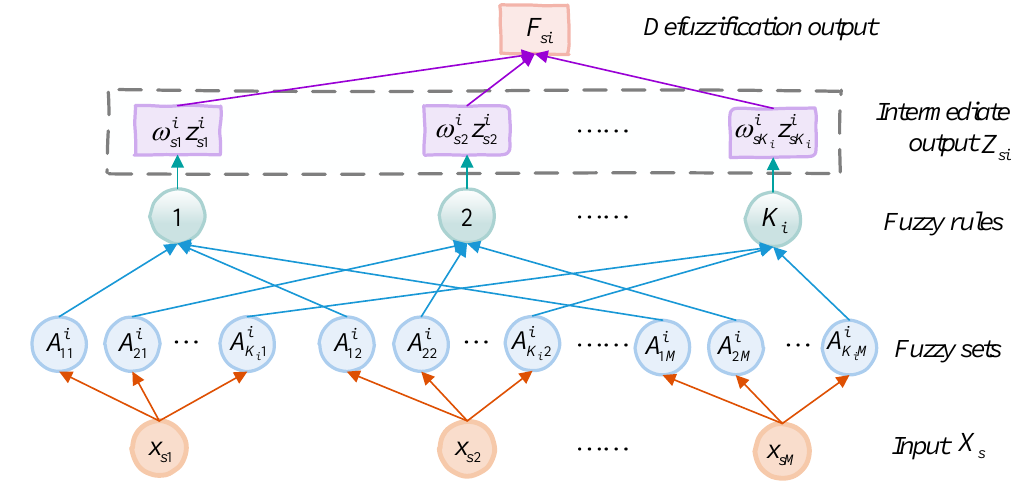
Figure 2. Fuzzy broad learning network structure.